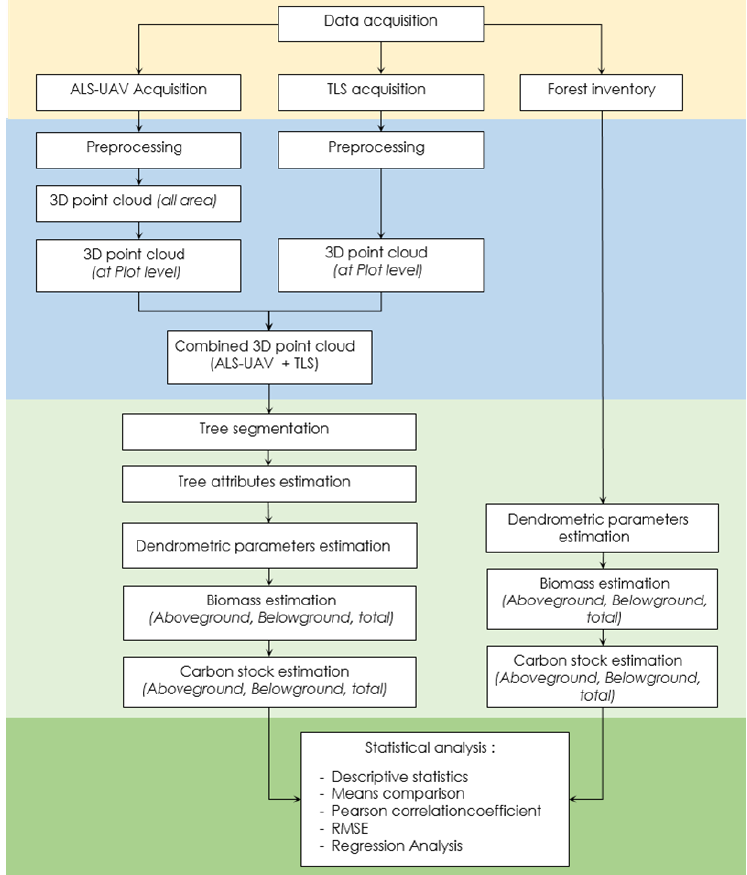
Figure 1. Flowchart of the research method.